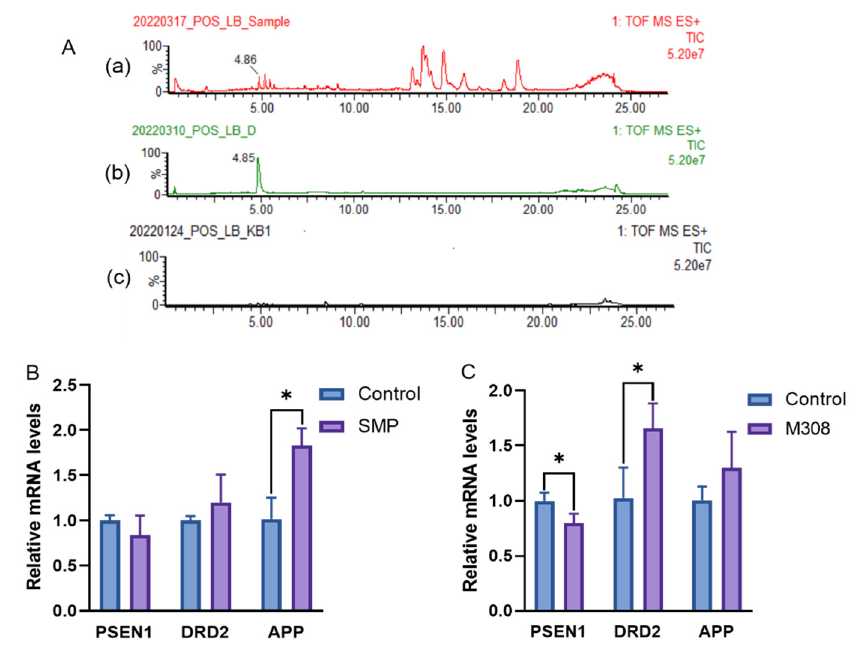
Figure 13. Effects of SMP (16%) and M308 (100 µ g/mL) on PSEN1, DRD2, and APP mRNA expression in the H 2 O 2 -treated PC12 cells. ( A ): the TIC of SMP ( a ), M308 ( b ), and blank plasm ( c ) under positive mode; the relative mRNA levels of PSEN1, DRD2, and APP under treatment of SMP ( B ) and M308 ( C ). SMP: Salvia miltiorrhiza-containing plasma; M308: Danshenxinkun D. The gene expressions were normalized to GAPDH and analyzed using the 2 − ∆∆ CT method. The Data were represented as the mean ± SD (n = 3). * p < 0.05 vs. the control group.